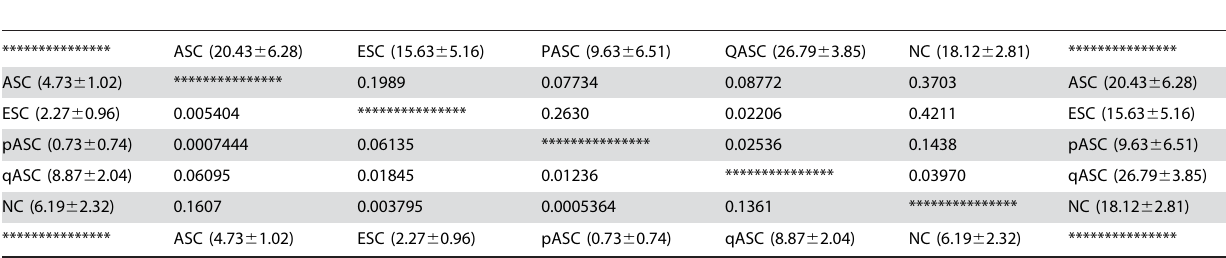
Table 7. The distribution of promoter usage in the different SC types and the negative controls (NCs); the upper right section of the table shows the CpG-rich APs and the lower left section the CpG-poor APs.